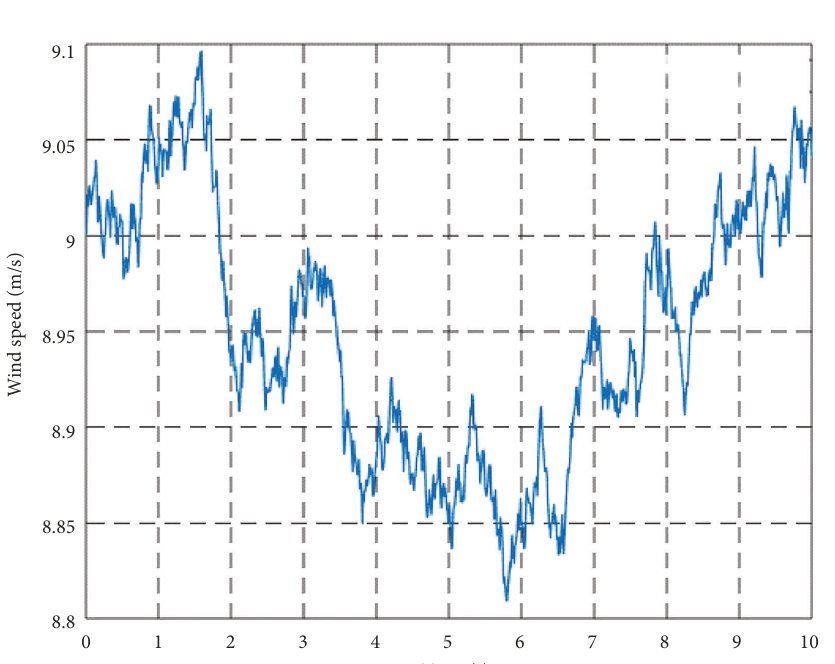
Figure 10: Output d Table 1: Fuzzy logic rules.